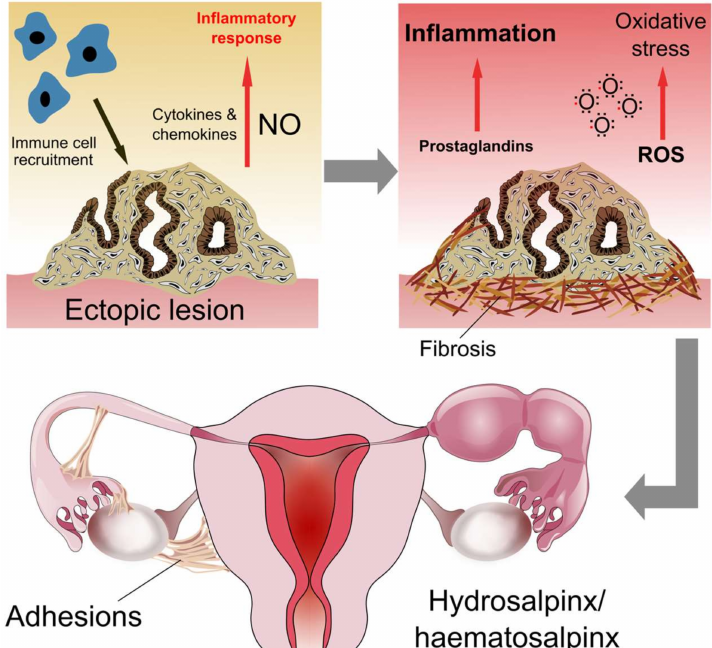
Figure 5. Inflammation in tubal endometriosis. Adhesion and proliferation of endometrial tissue at ectopic sites leads to an influx of immune cells, secretion of cytokines / chemokines and initiation